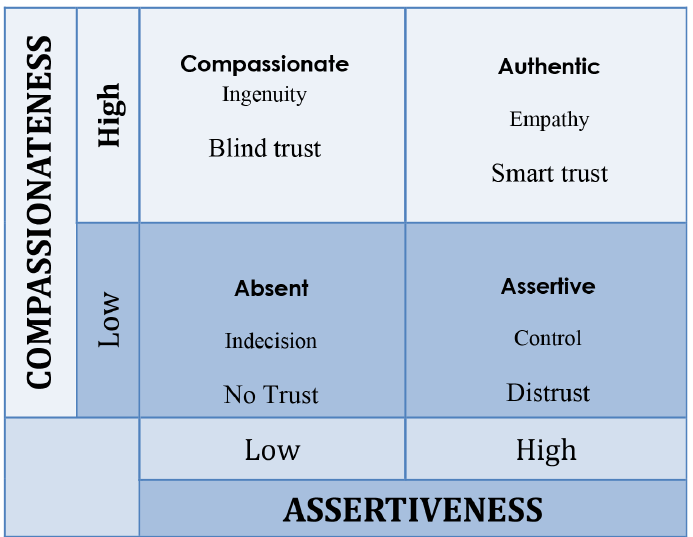
Figure 2. Matrix of principals’ perceived